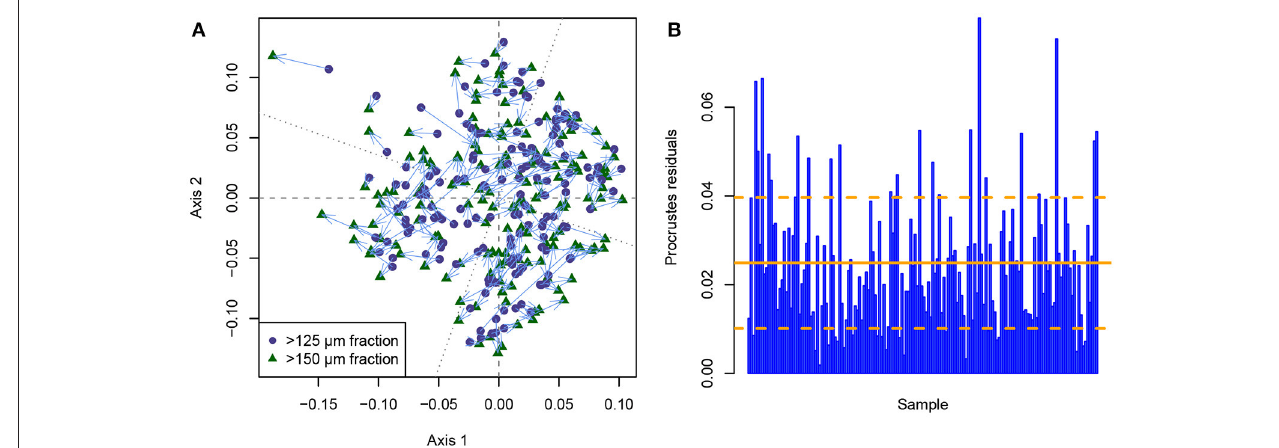
FIGURE 5 | Comparison between the metric multidimensional scaling (MDS) solutions of the benthic foraminiferal assemblages from the >125 and >150µm size fraction from the Pefka E section using Procrustes normalization. (A) Symmetrical Procrustes scaling of the >125µm MDS solution on the >150µm MDS solution as target. Corresponding points are linked via light blue arrows. The principal axes of the target (dashed) and scaled (dotted) MDS solution are indicated by gray lines. (B) Procrustes residuals (distance between rotated and target point in scaled configuration) per sample. The mean (solid orange line) and standard deviation (dashed orange lines) of the Procrustes residuals are